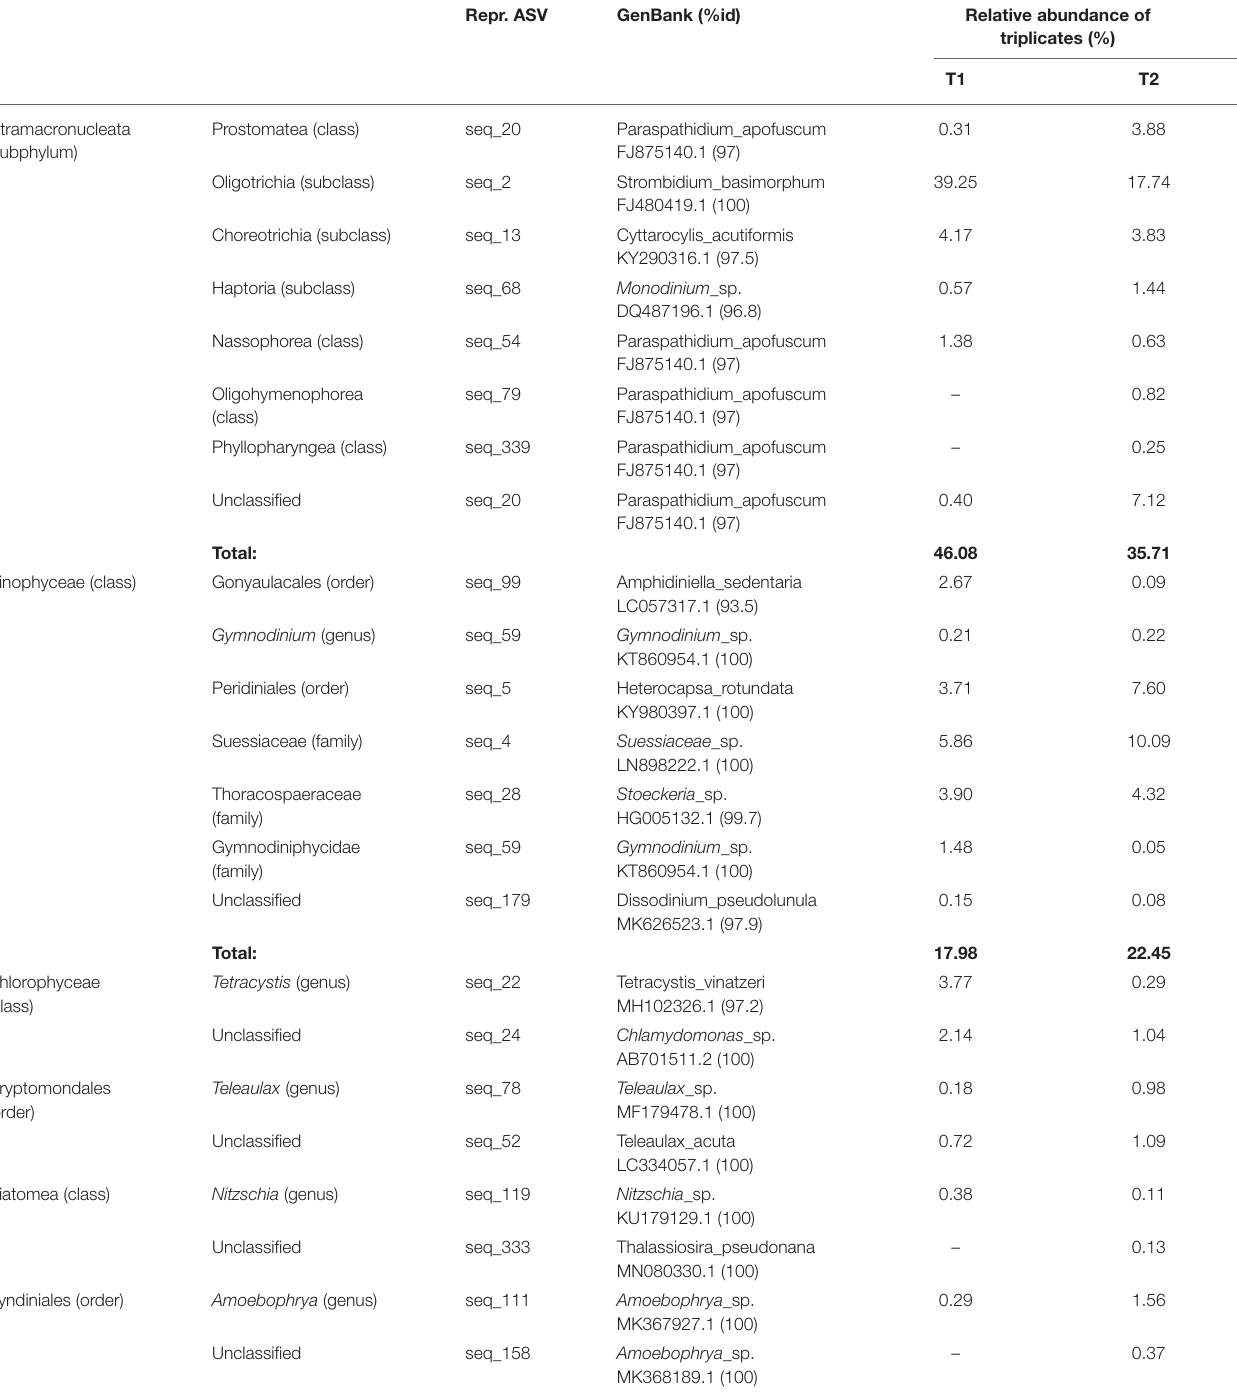
TABLE 2 | Taxons, at two levels, of representative PE ASVs (18S), with accession numbers for matches in GenBank with %